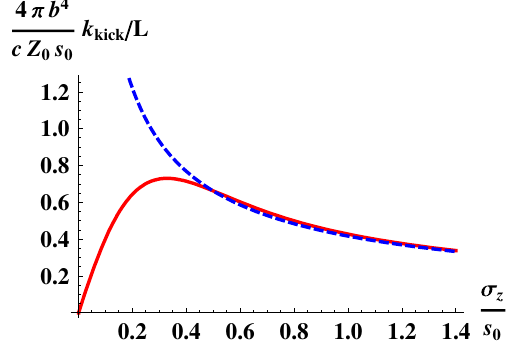
FIG. 5. (Color) Kick factor given by Eq. (48) (solid) and long- range approximation from Eq. (40)